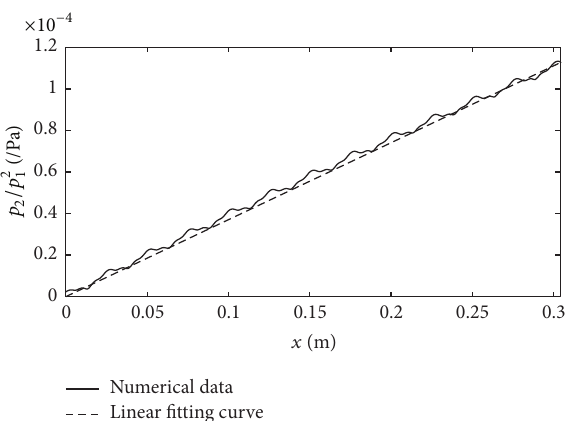
Figure 3: Second harmonic of pressure as a function of the square of the fundamental versus distance from the source. Bubble radius is = 7 𝜇 m, bubble density is 𝑁 𝑅 0𝑟 = 20 kHz, and pressure amplitude at the source is 𝑝 𝑓 𝑟